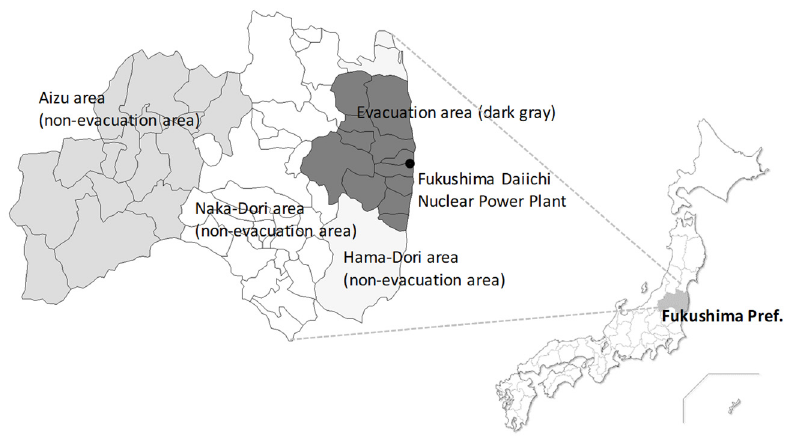
Figure 1. Areas within Fukushima Prefecture (evacuation area, and Hama-Dori, Naka-Dori, and Aizu).